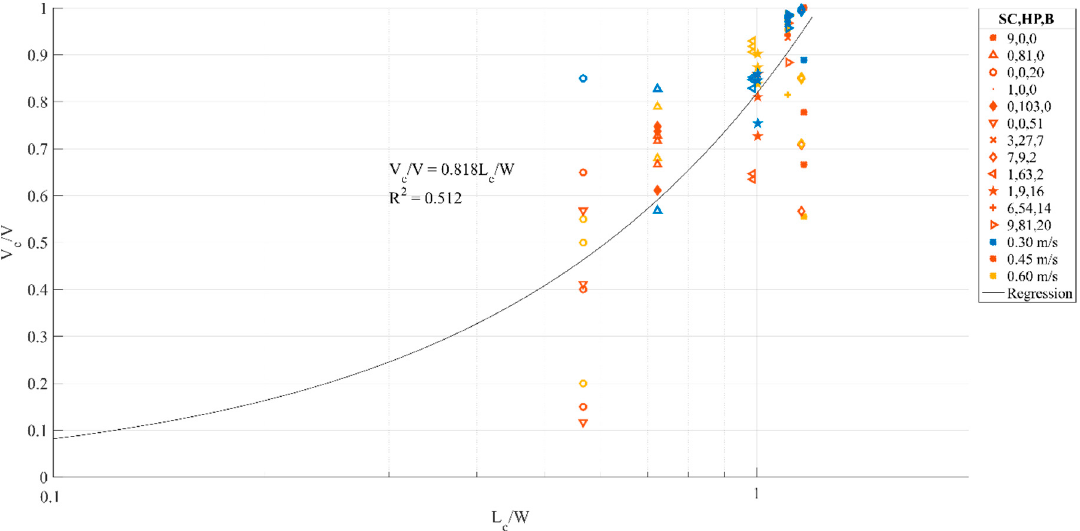
Figure 10. Capture efficiency as a function of the characteristic length of the debris source. The debris configuration indicated by the marker type, flow condition indicated by the color.